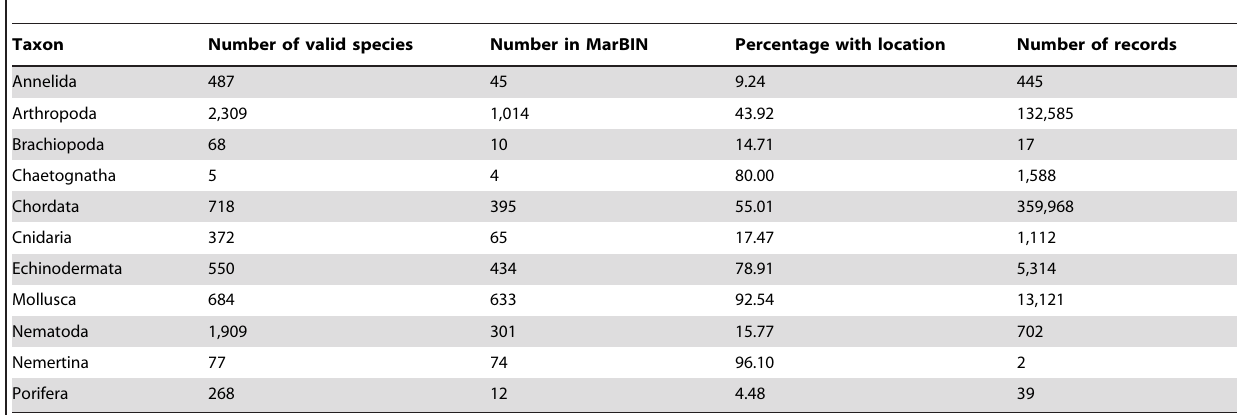
Table 2. The numbers of various taxa represented in the Register of Antarctic Marine Species and